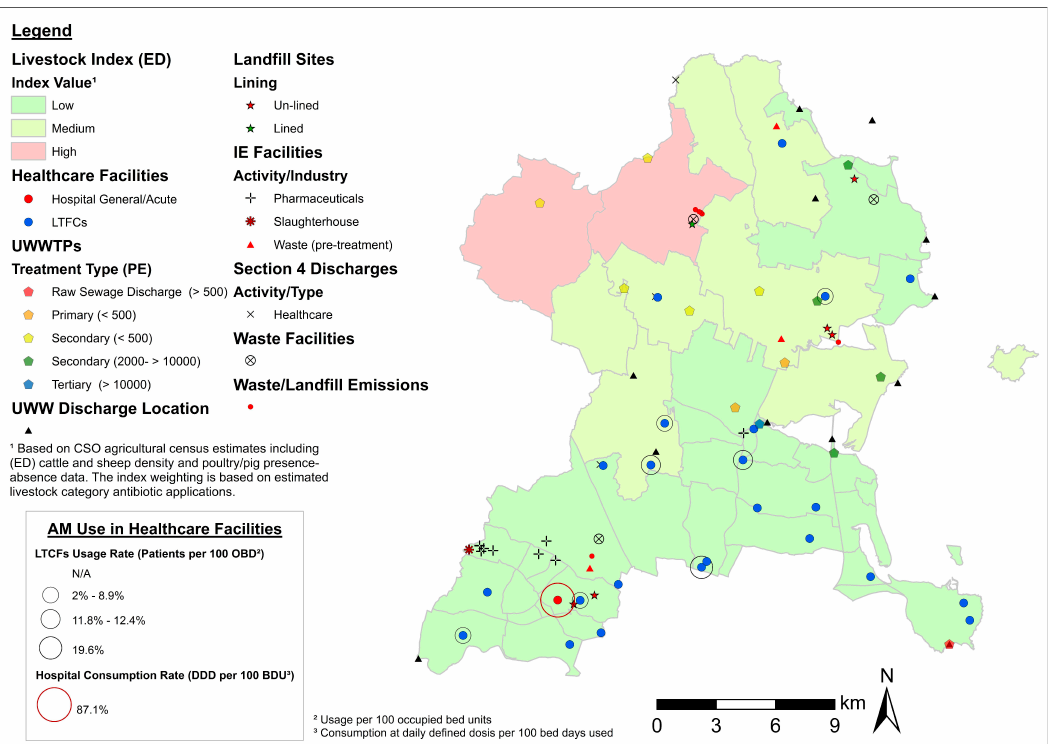
Figure 4. Map of potential ARO sources (classified) and healthcare facilities (including AM use) in Fingal County. Notes: Livestock index estimates are included as a base map layer. ED = electoral district. Blanchardstown—the ward is highlighted. UWWTPs = urban wastewater treatment plants. UWW = urban wastewater. IE = industrial emissions. PE = population equivalent (i.e., estimated population served by